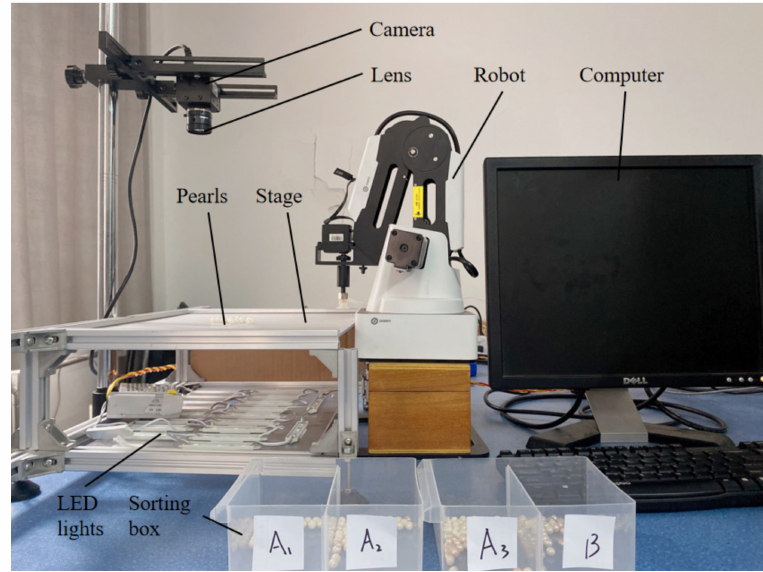
Figure 1. Pearl shape detection system platform.